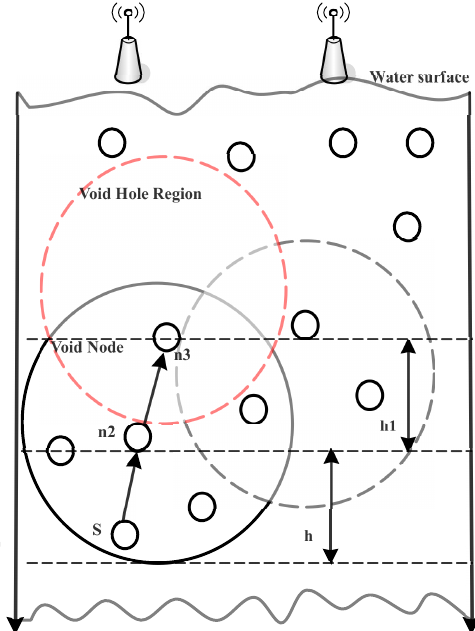
Figure 1. Illustration of the void hole problem in